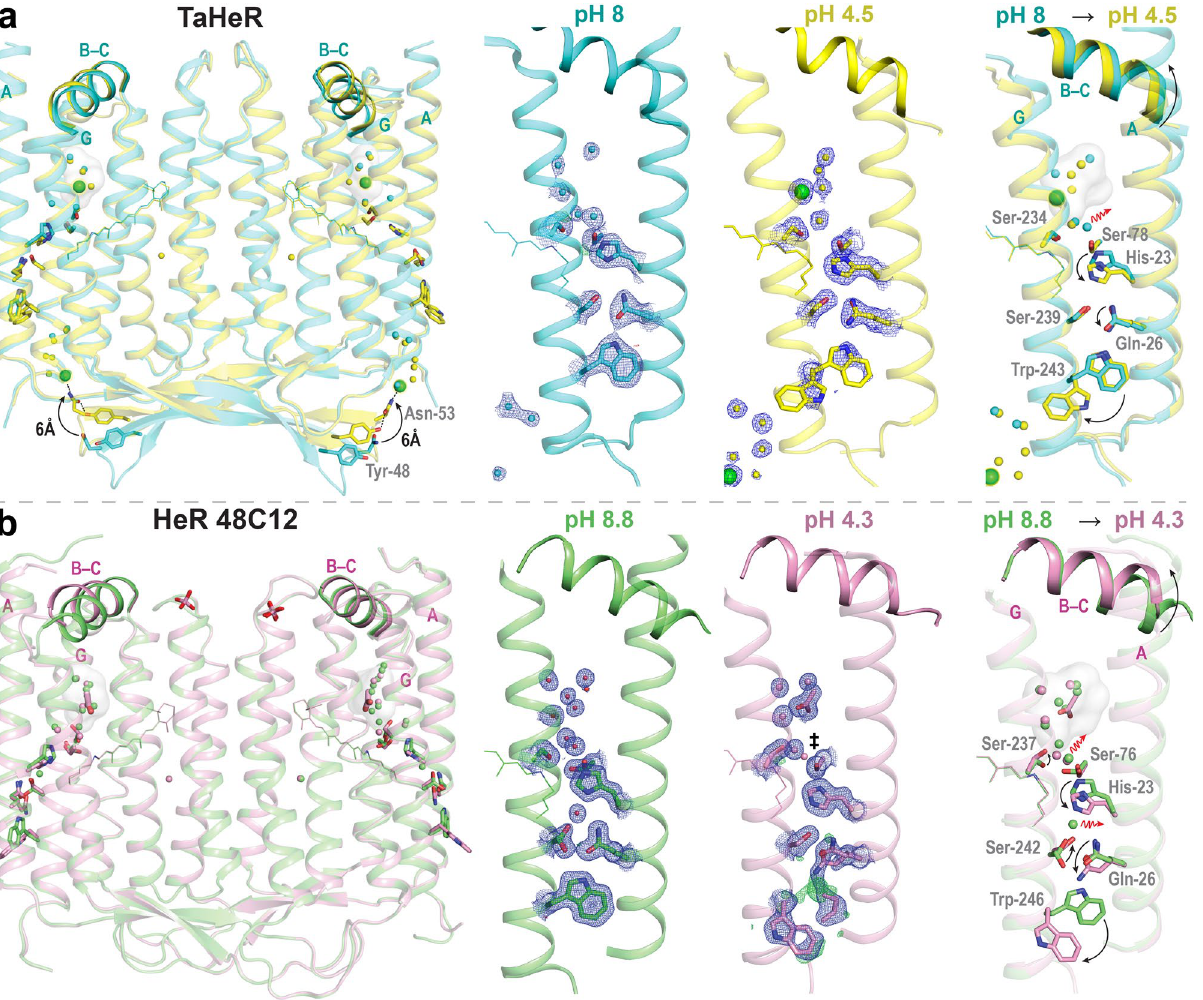
Figure 5. A putatively conserved intramolecular signaling pathway for TaHeR and HeR 48C12. ( a ) TaHeR dimer structure at pH 8 (cyan, PDB ID 6is6) and pH 4.5 (yellow, PDB ID 7u55). ( b ) HeR 48C12 dimer structure at pH 8.8 (green, PDB ID 6su3) and pH 4.3 (pink, PDB ID 6su4). The conserved intramolecular signaling mechanism involves a negatively charged anion (chloride or acetate) occupying the SBC (grey surface), switching the orientation of His-23, displacing water molecules (red arrows), disordering Gln-26 and disordering Trp-243 (in TaHeR) or Trp-246 (in HeR 48C12). The overlay reveals there is a 1 Å movement of the intracellular B–C loop. TaHeR has an additional 6 Å shift of the A − B tail from the electrostatic attraction of Tyr-48 and Asn-53 to an external chloride ion. Waters are shown as small spheres colored to match protein, and chloride ions as large green spheres (belonging to pH 4.5 TaHeR only). The 2Fo − Fc maps (blue mesh) are contoured at 1 σ, and Fo − Fc is contoured at + 3 σ for positive (green mesh) and − 3 σ for negative (red mesh) electron density, respectively. ‡ In HeR 48C12 at pH 4.3, there is no electron density to account for this water in the chain A